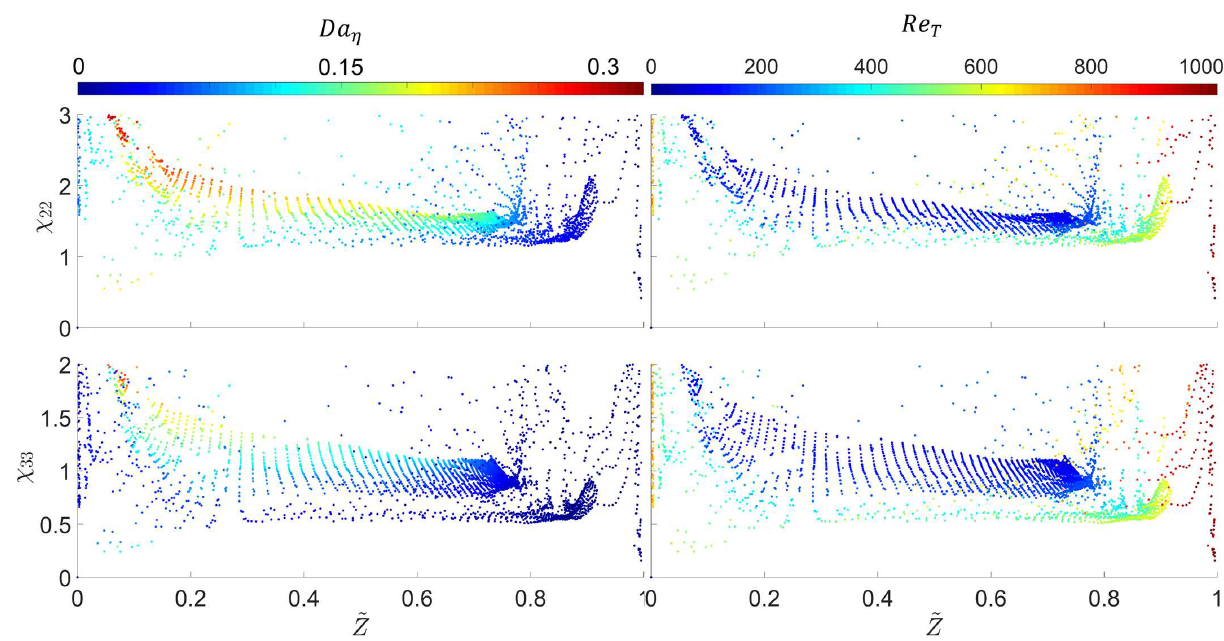
Figure 10. Estimated values for χ nn as a function of the Favre-averaged mixture fraction (cid:101) Z , the Damköhler number of the Kolmogorov eddies Da η , and the turbulent Reynolds number Re T for Re T > 70 .